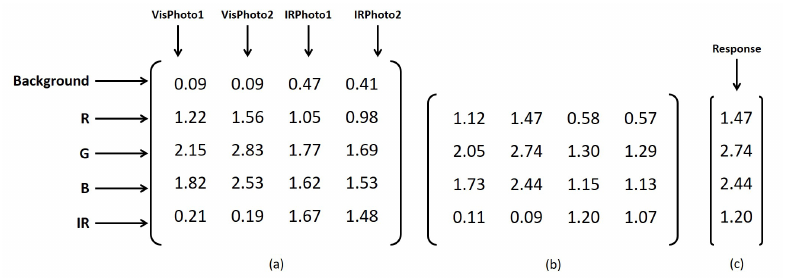
Figure 5. Example of data processing steps with typical data: ( a ) matrix of measured voltages obtained at the end of each measurement cycle ( b ) matrix of measured voltages with the background radiation subtracted off and ( c ) response vector generated after processing the measured